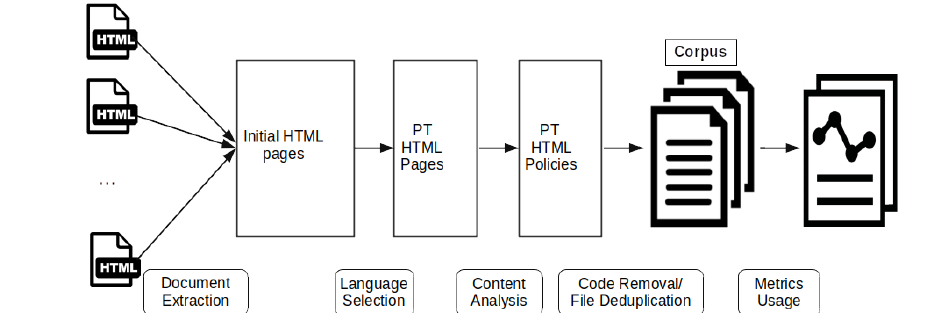
Figure 1. Steps performed during document collection, treatment and analysis.